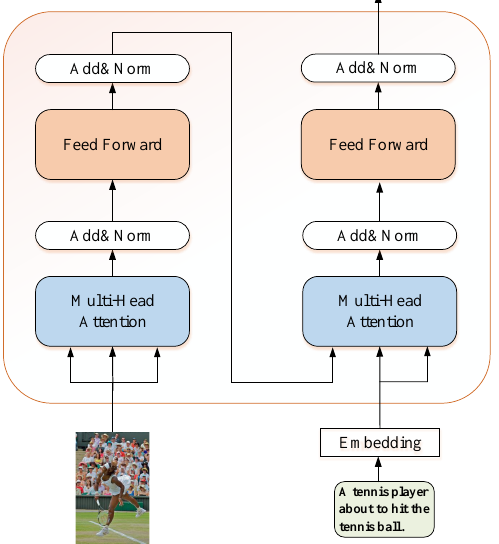
Figure 2. The left part is a visual encoder, the right part is the de-noising module. Here we list one of the retrieved similar